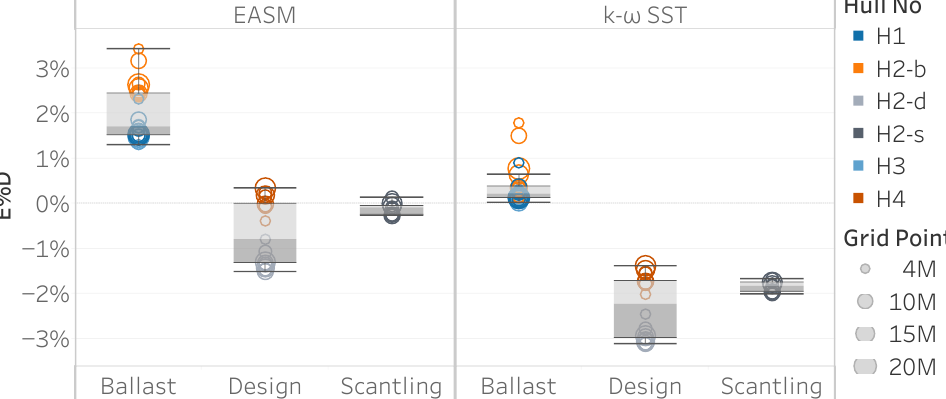
Figure 11. Comparison error of form factors for different loading conditions for the EASM and the k − ω SST turbulence